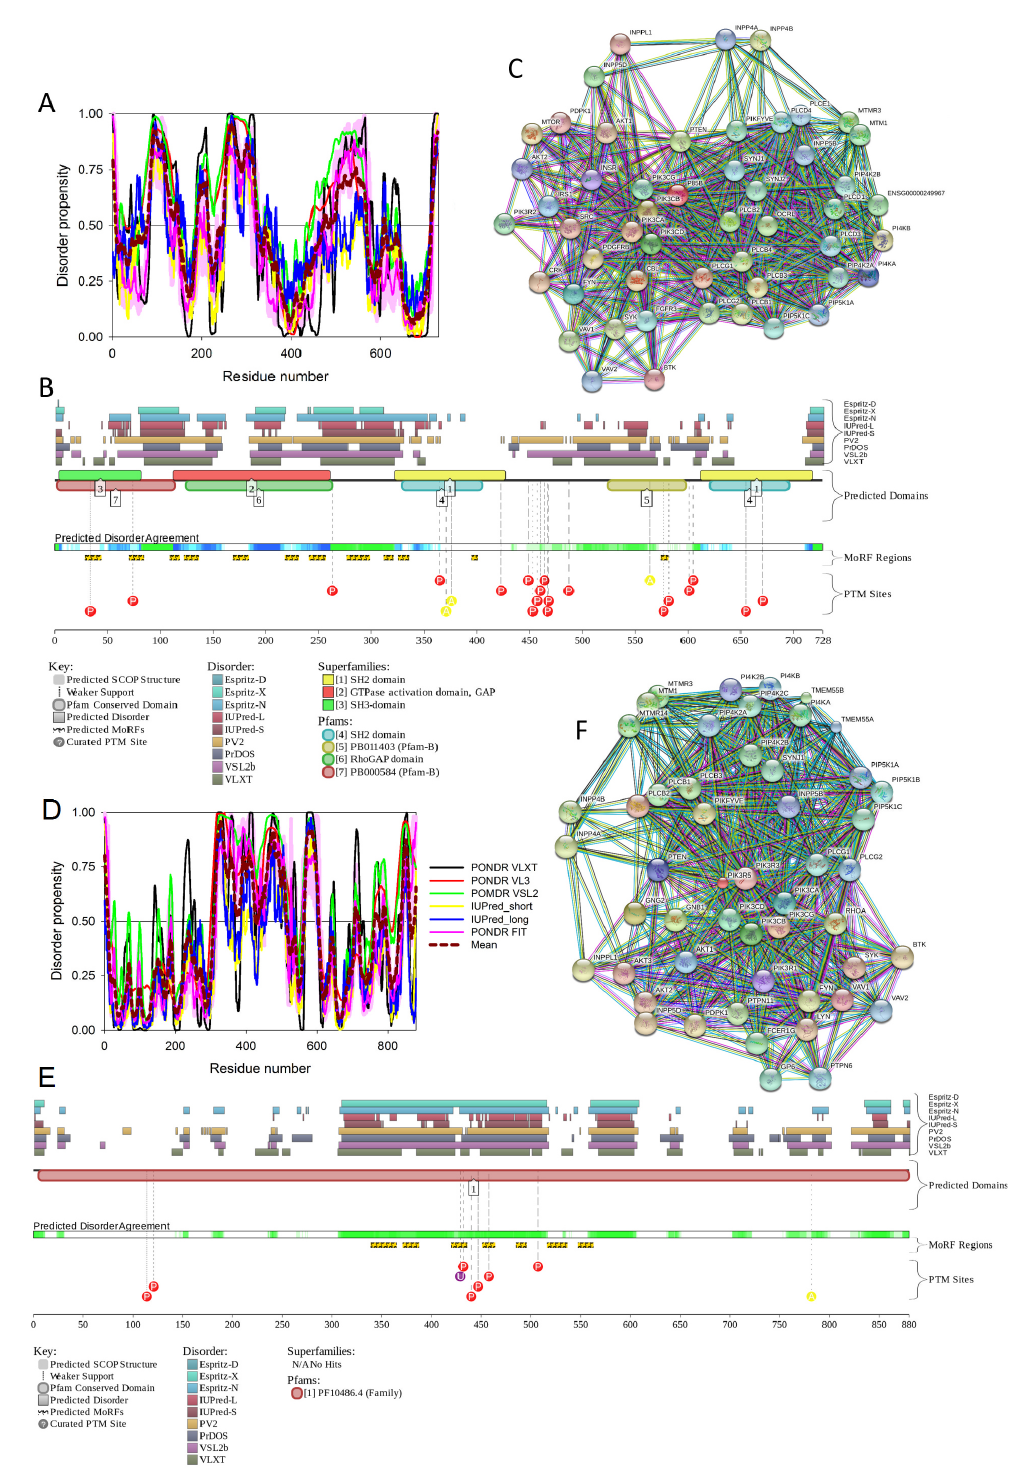
Figure 14. Multiparametric analysis of functional intrinsic disorder and interactability of human PIK3R2 (UniProt ID: O00459, ( A – C ) and PIK3R5 (UniProt ID: Q8WYR1, ( D – F ) proteins. ( A , D ) Evaluating intrinsic disorder propensity by per-residue disorder predictors, PONDR ® VLXT, PONDR ® VSL2, PONDR ® VL3, IUPred_short, IUPred_long and PONDR ® FIT. ( B , E ) Analysis of the intrinsic disorder propensity and some important disorder-related functional information generated by the D 2 P 2 database (available online: http://d2p2.pro/). ( C , F ) STRING-based analysis of the interactivity of human PIK3R2 and PIK3R5